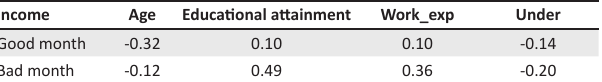
TABLE 5: Waste picker correlation matrix: The possible association of skills- related underemployment on income. Income Age Educational attainment